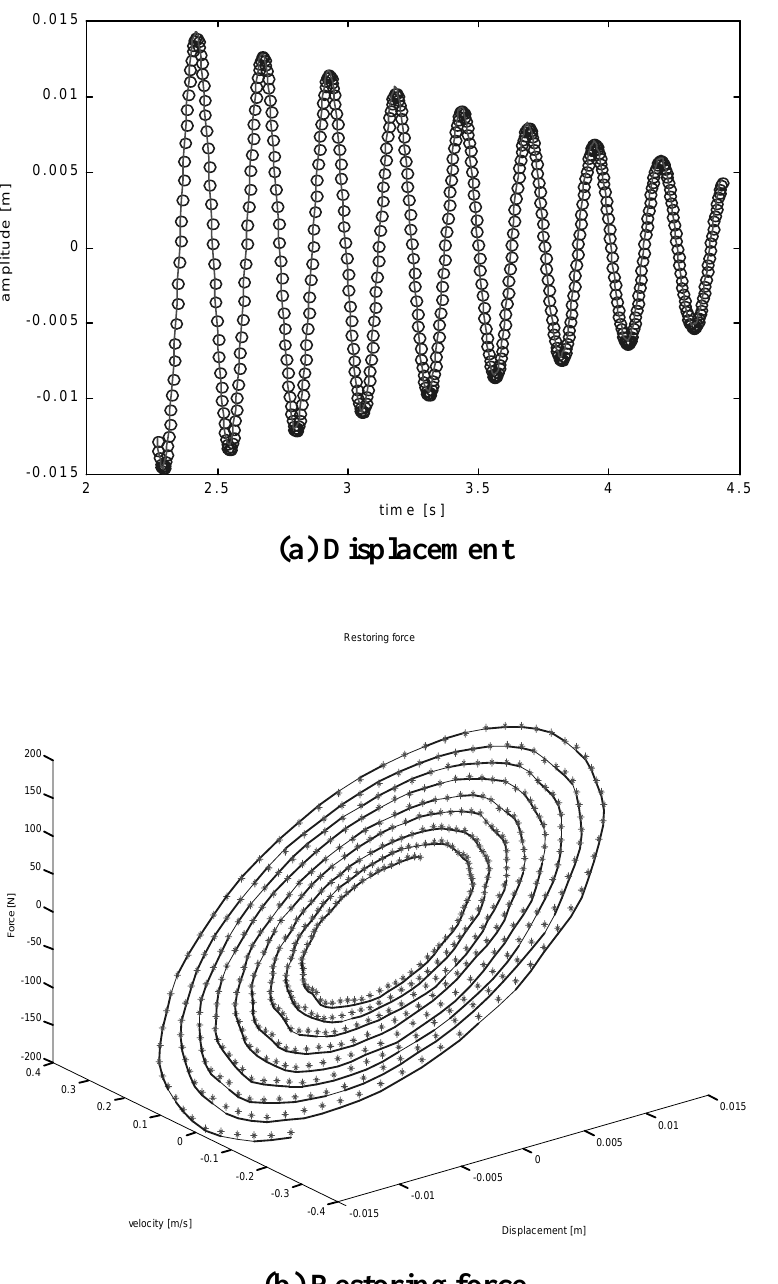
Fig. 5. Comparison between measured ( − ) and predicted (o) signals (WT method).